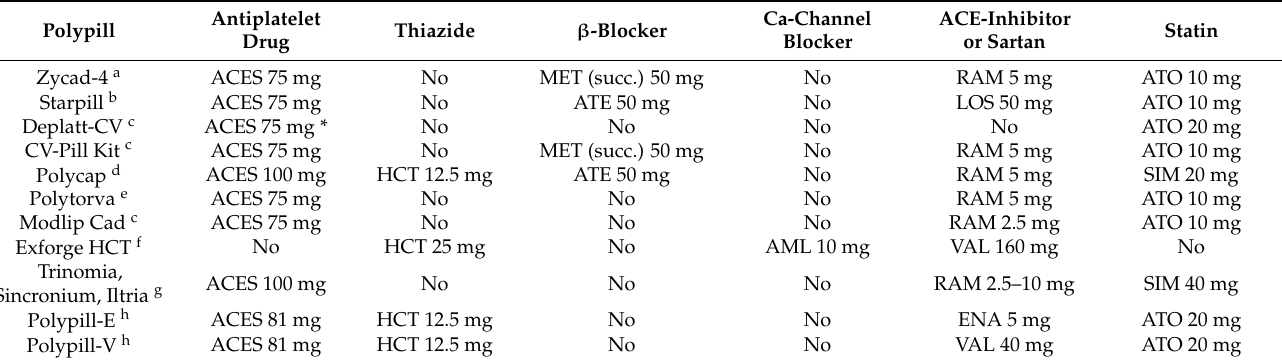
Table 1. Fixed-dose combination drugs used in the treatment of hypertension